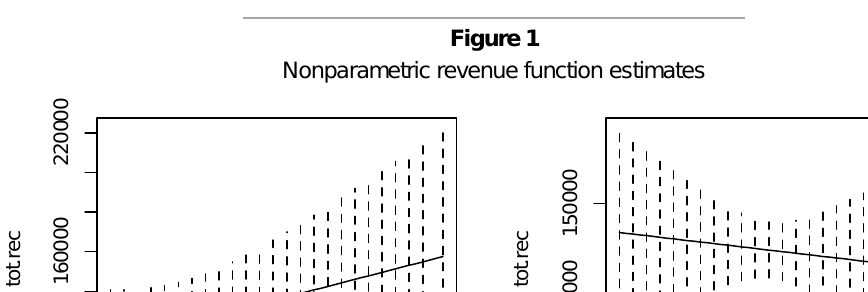
Nonparametric revenue function